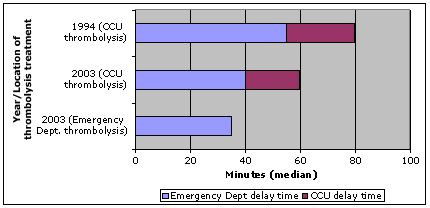
Thrombolysis administration locations and treatment times in 1994 and 2003